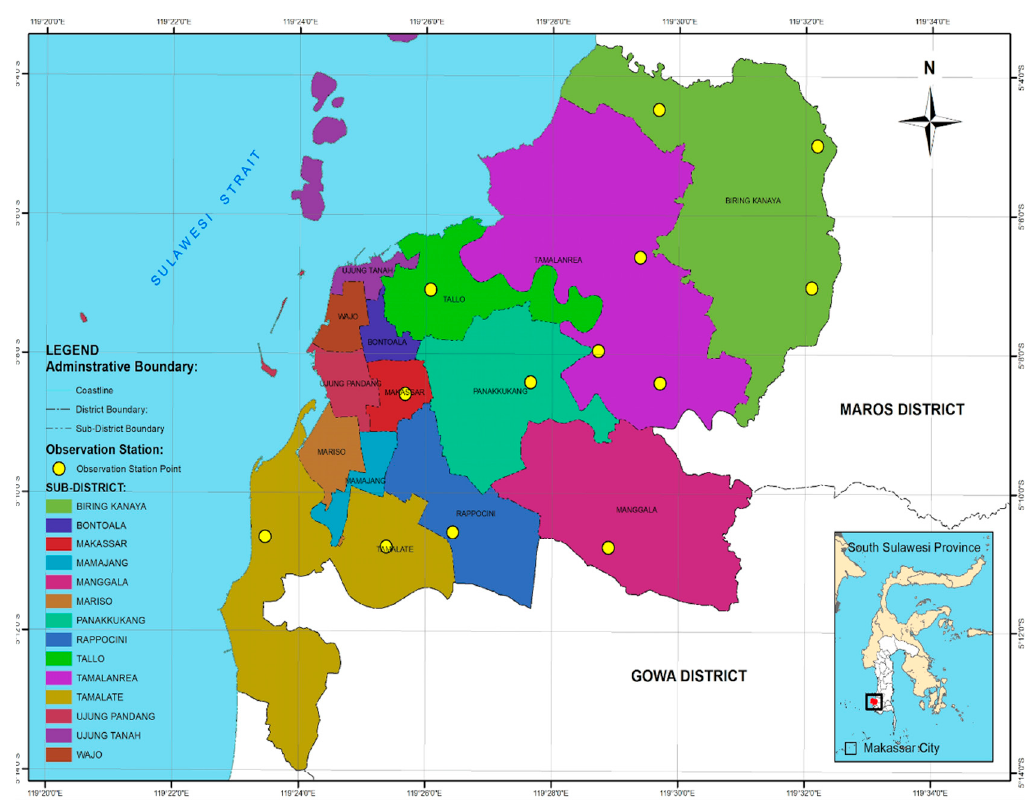
Figure 1. Map of observation stations in Makassar City, South Sulawesi Province, Indonesia.